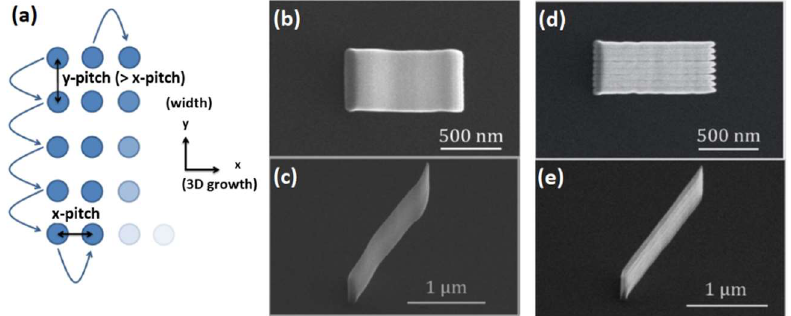
Figure 6. Dual-pitch nanopatterning. ( a ) Defining ‘x’ as the direction of 3D growth, a transverse pitch is defined along the ‘y’ direction in order to create structures with controllable width. The beam scanning strategy after addition of the ‘y’ pitch follows a serpentine pattern starting from the top-left site, as indicated by the arrows; ( b , c ) Top and side views of a wide nano-ramp grown using an optimized y-pitch of 30 nm; ( d , e ) Top and side views of a wide nano-ramp grown using a y-pitch of 60 nm.